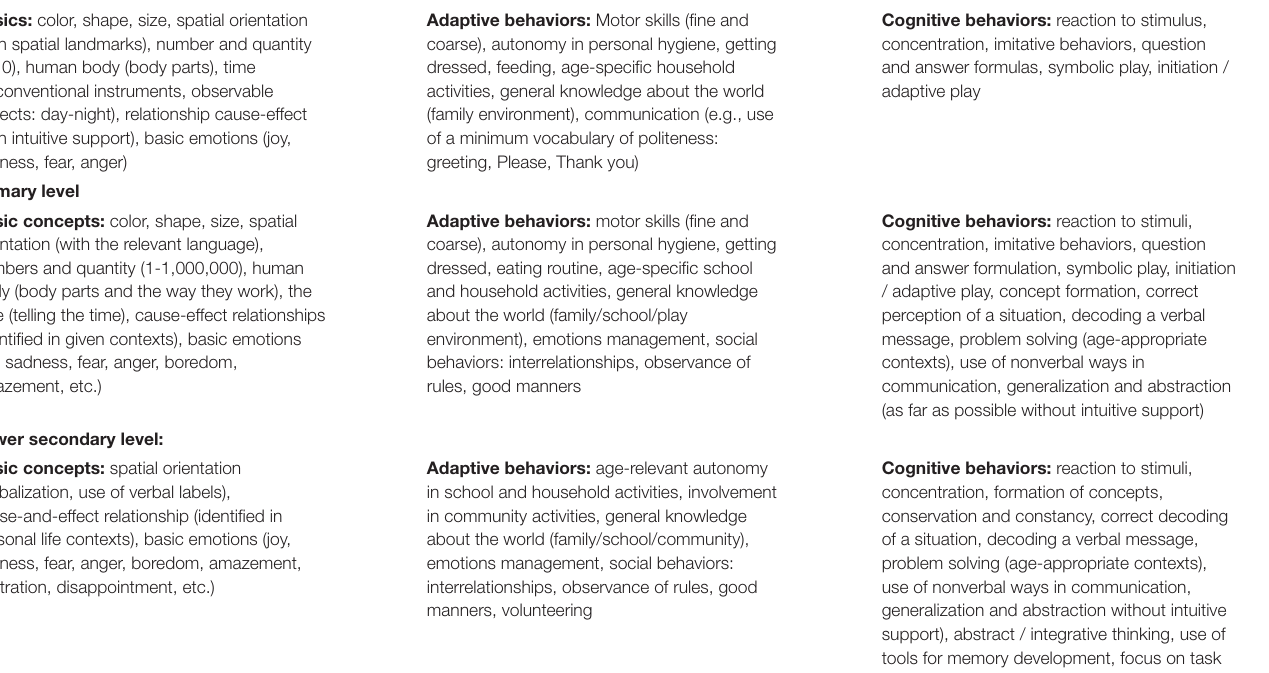
TABLE 1 | CORTTEX curriculum structure. Preschool